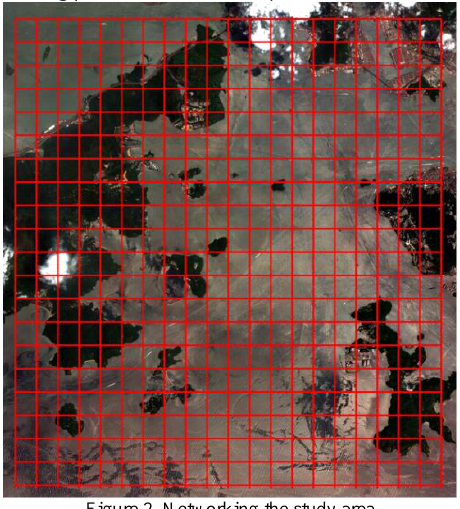
Figure 2. Networking the study